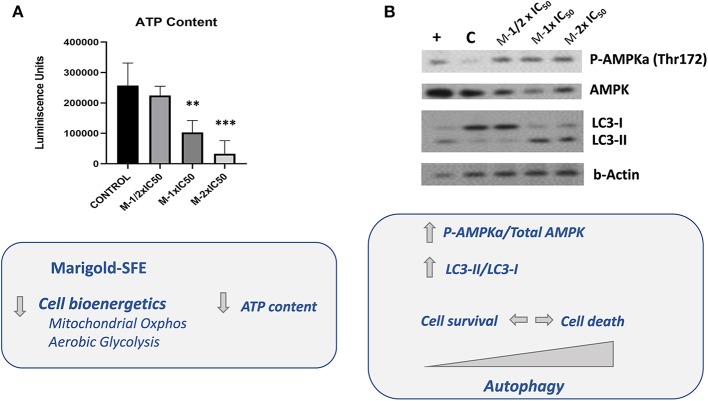
Marigold SFE leads to AMPK activation and increased markers of autophagy (LC3-II). (A) Measurement of the intracellular ATP content. Luminescence units were registered for marigold SFE pretreated cells (½ × IC50, 1 × IC50, and 2 × IC50) and compared to control non-treated cells. (B) Western blot analysis of P-(Thr172) AMPK and Total AMPK protein levels, and LC3 protein. Cells incubated for 6 h in low glucose (2.5 mM) were kept as a positive control of AMPK activation and LC3 lipidated form (LC3-II). **P < 0.01, ***P < 0.005.